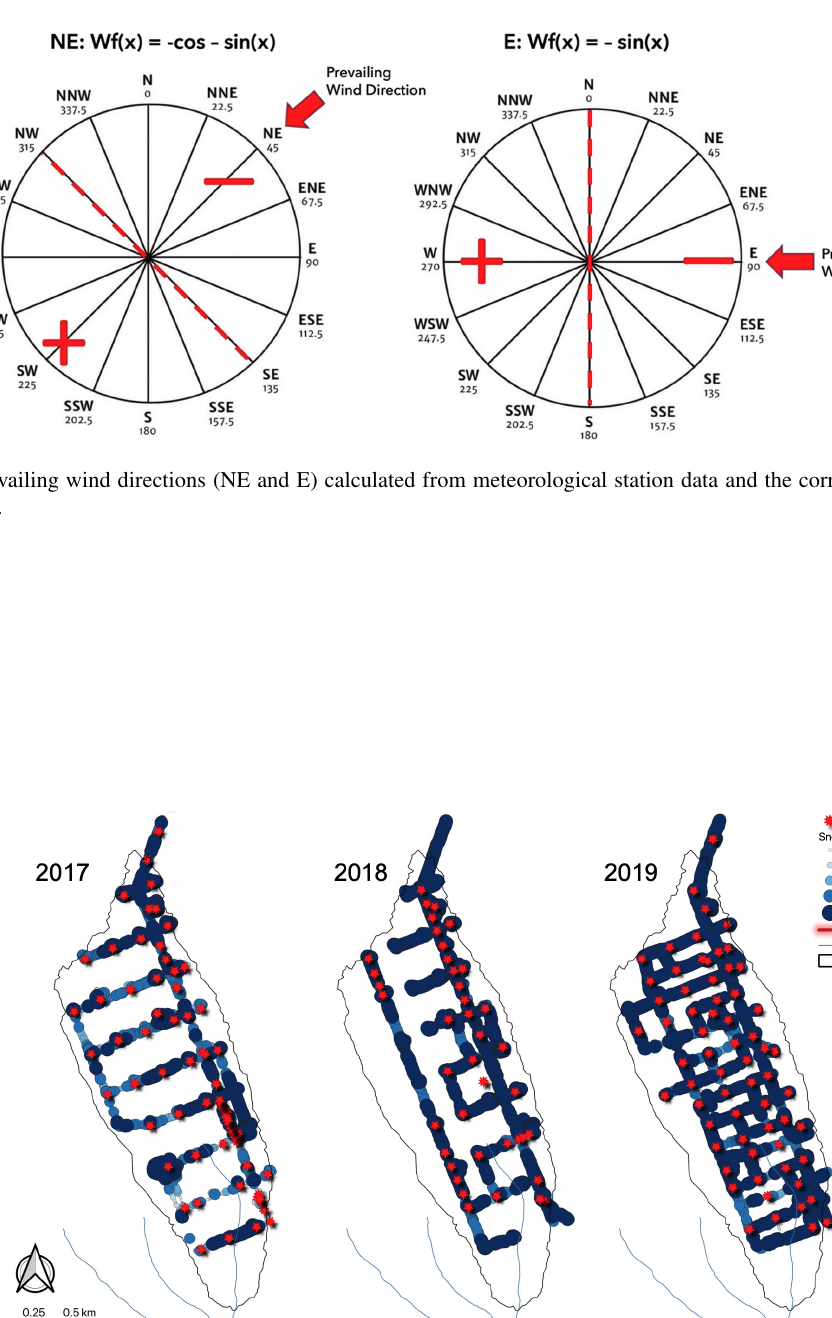
The Cryosphere, 16, 3269–3293,